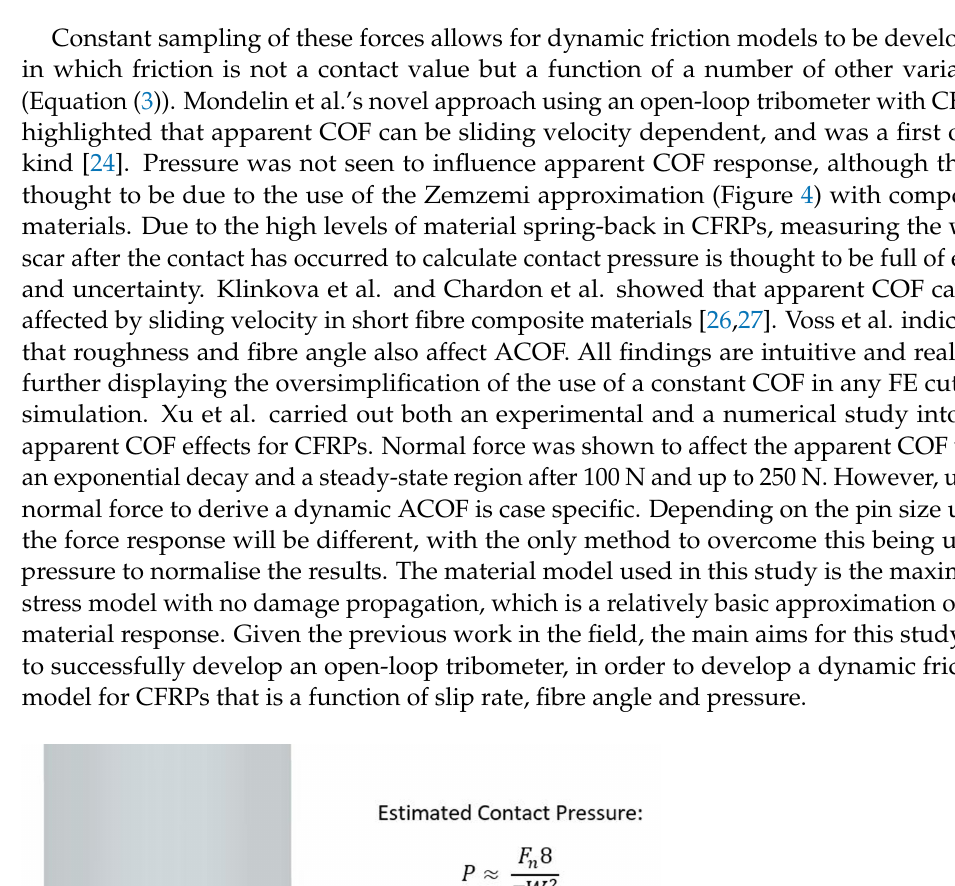
Figure 3. CFRP open-loop tribometer diagram with forces.